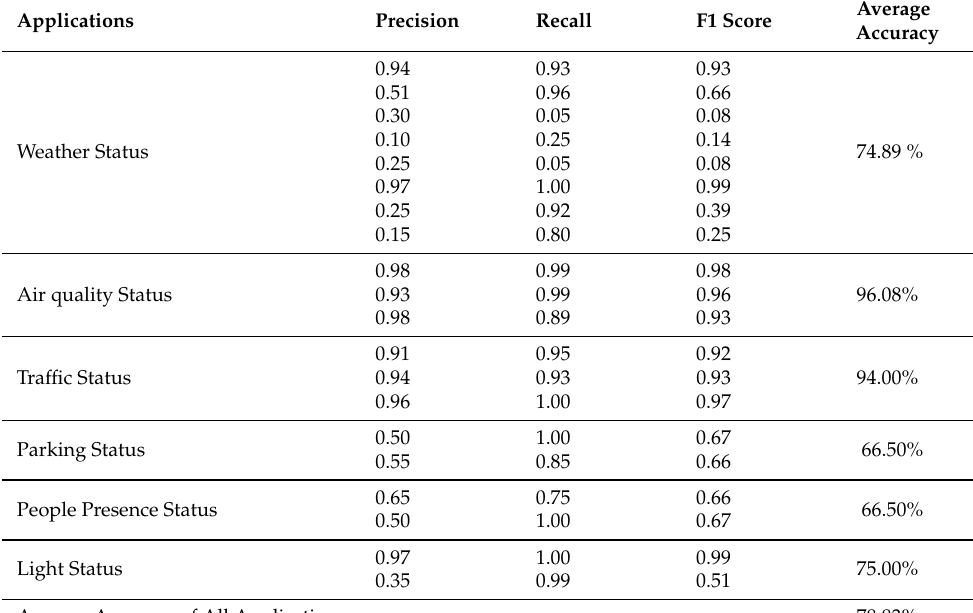
Table 8. Classification report of existing